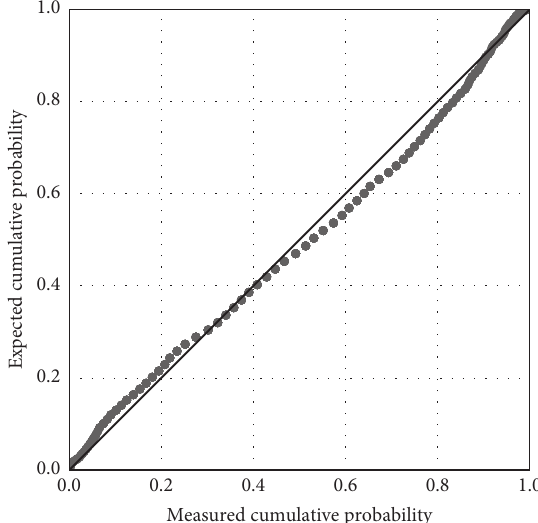
Figure 4: Detrended normal P − P diagram Reaction time after natural logarithm